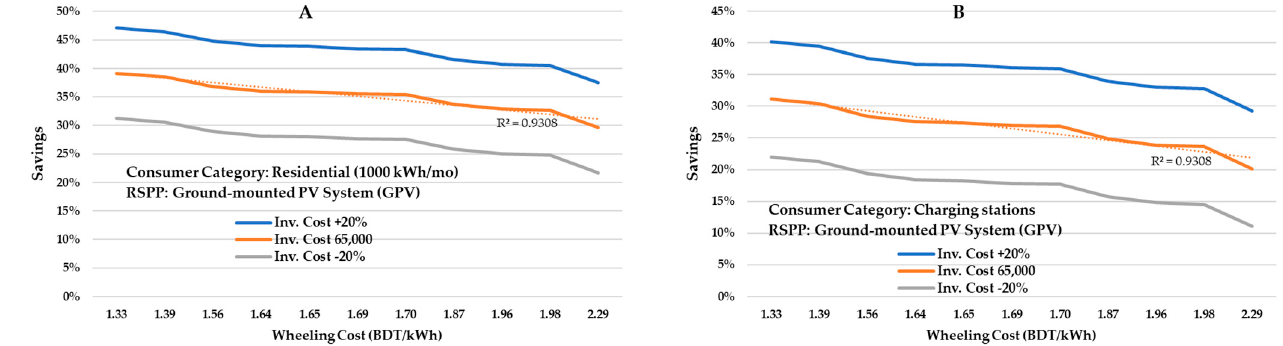
Figure 11. Impacts of investment and wheeling costs on savings for using VNM. RSPP = GPV. ( A ) For the charging station consumer category and ( B ) for the residential (1000 kWh/month) consumer category.